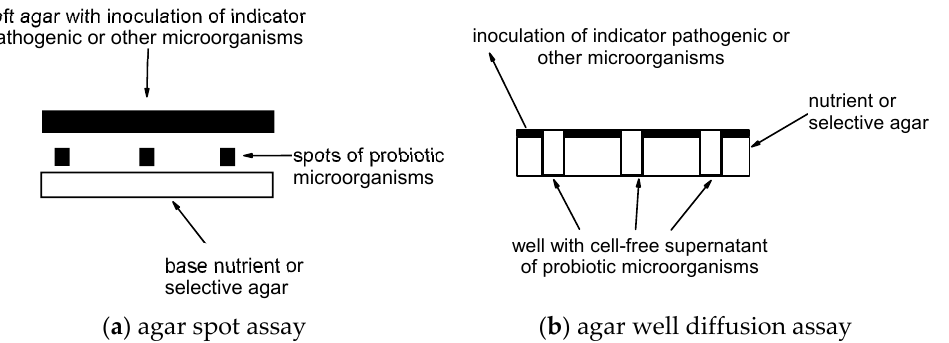
Figure 1. Scheme of the agar spot assay and the agar well diffusion assay. Adapted from Fijan, 2016 [59].